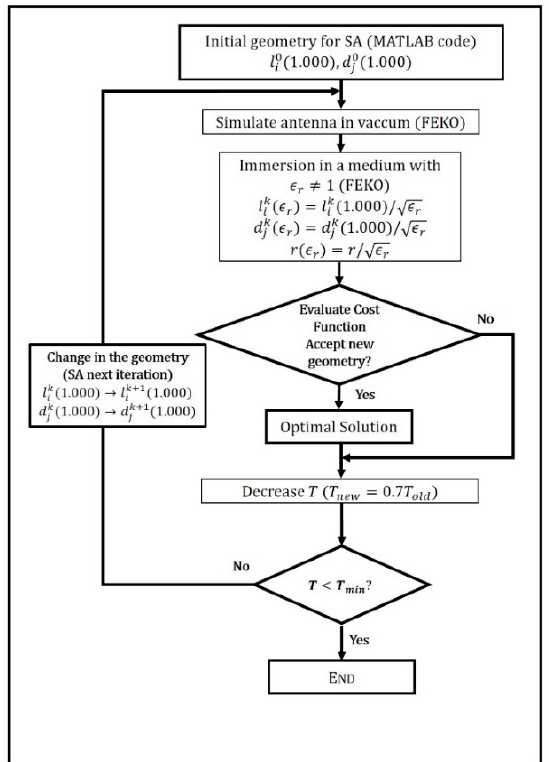
Figure 2. Flowchart of the optimization strategy combined with the numerical approach for the immersion process of the Yagi–Uda-like antennas in a dielectric medium. The parameters l i and d i are the lengths and spacings (in terms of λ ) and r are the radii of the antennas, which have been fixed to a value of 0.75 mm in the vacuum. The initial value of the T parameter involved in this SA strategy (linked to the randomness of the search of the algorithm) was set as 100.